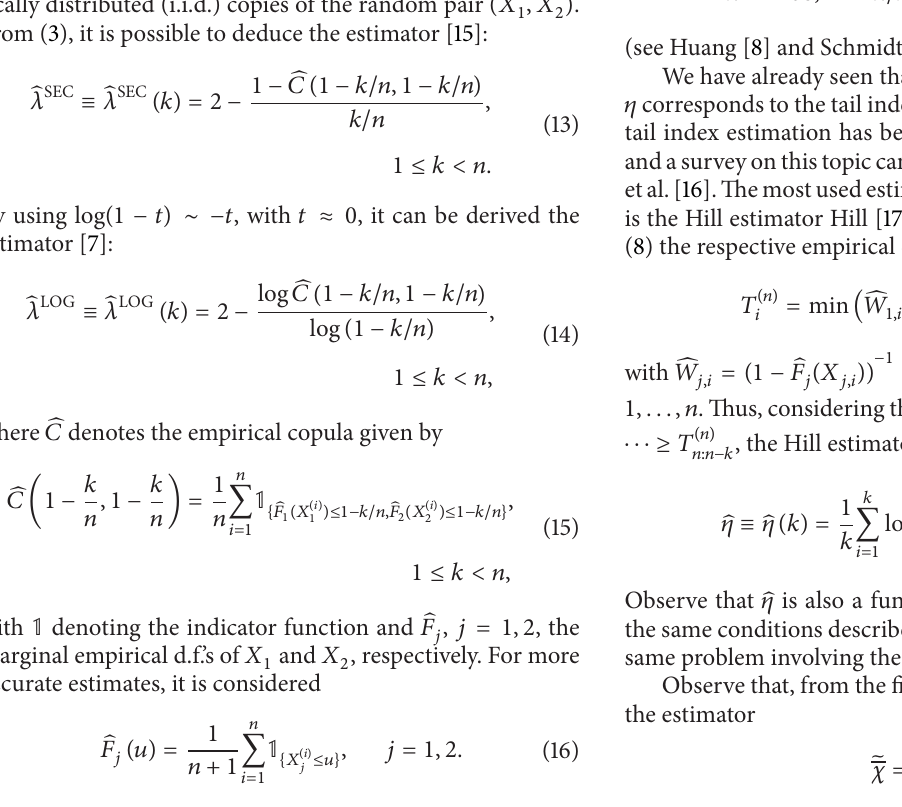
Figure 1: Sample path of estimator bivariate Student 𝑡 . The horizontal lines correspond to the true